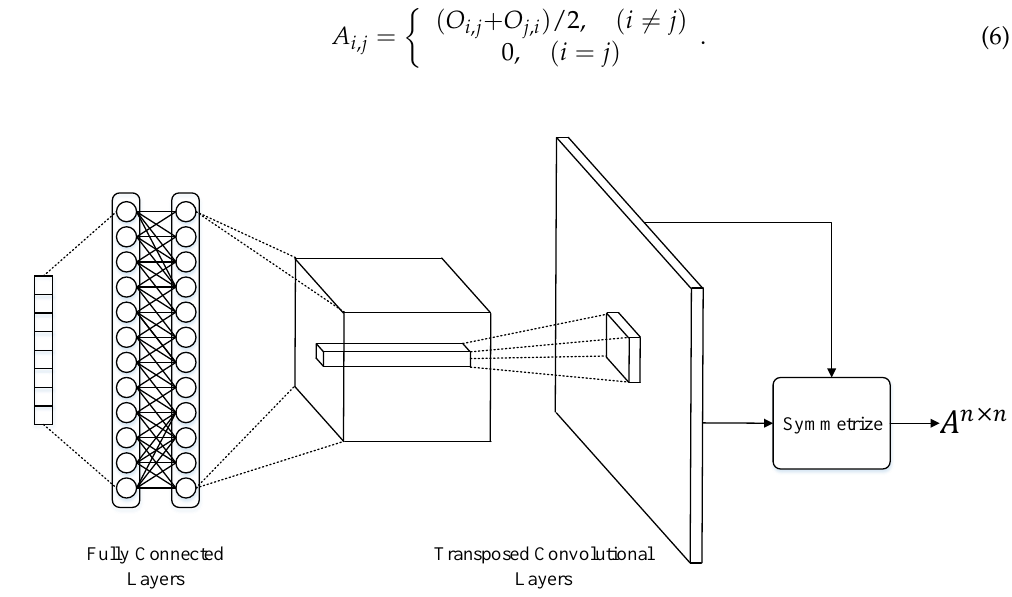
Figure 3. Implementation details of the interaction matrix